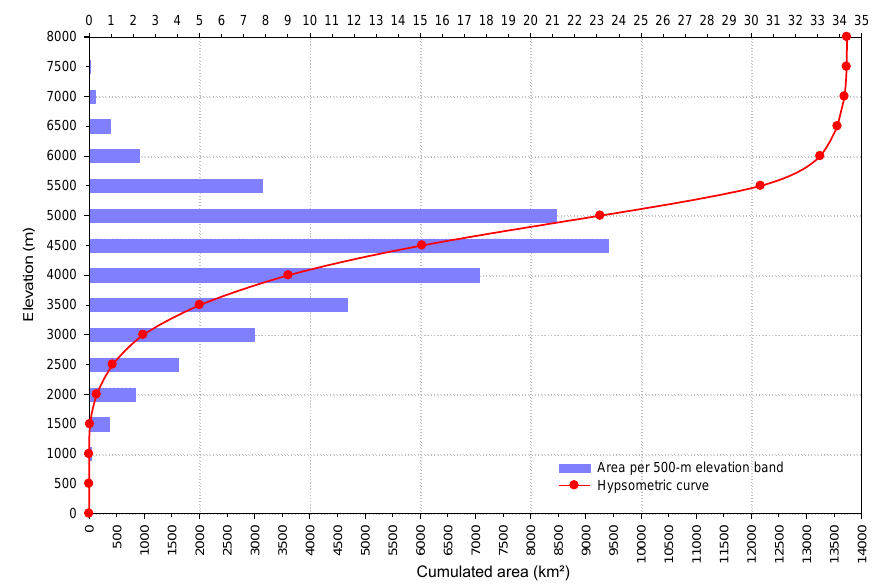
Fig. 3 Hypsometric curve of the Hunza River basin and distribution of the area by layer under each 500-m elevation band.